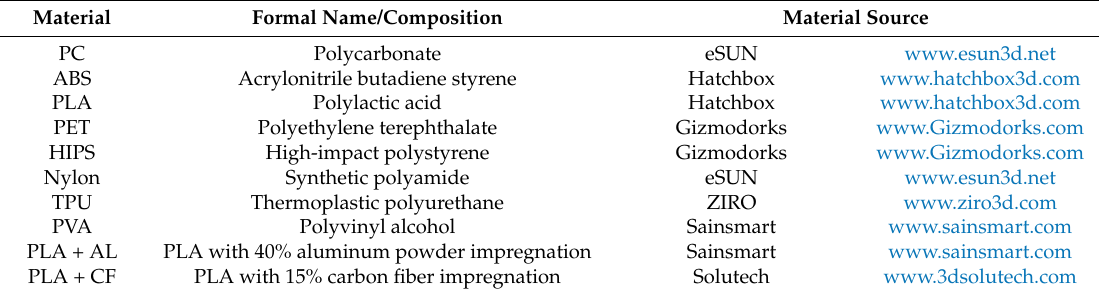
Table 1. FDM materials used.